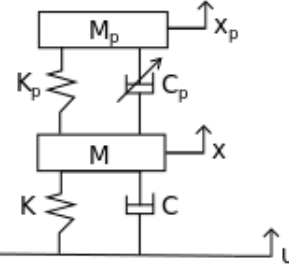
Figure 9. Mathematical